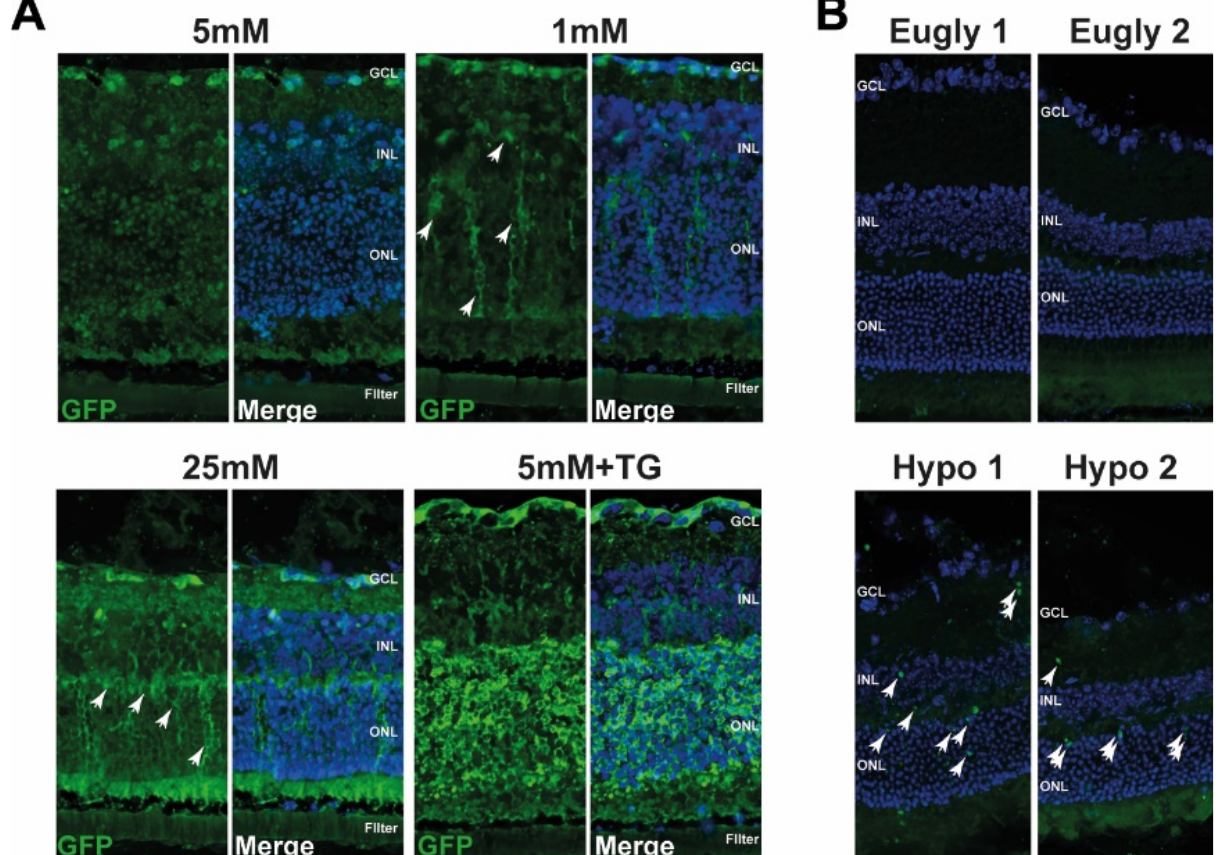
Figure 3. Xbp-1 splicing is activated in ERAI tg/+ retinal explants after 48 h and after a 5 h hypoglycaemic clamp. ( A ) Confocal images showing retinal explants from ERAI tg/+ mice cultured at different glucose conditions (1 mM, 25 mM or 5 mM with or without TG). White arrows indicate GFP-positive cells and nuclei are counterstained with DAPI. Results are representative of 2 retinal explants per condition. ( B ) Endogenous GFP detection (white arrows) in the retina of mice subjected to a hypoglycaemic (Hypo1 and Hypo2) or euglycaemic (Eugly1 and Eugly2) clamp; nuclei are counterstained with DAPI. Eyes were isolated 4 h after the end of the clamp. Results are representative of 4 retinas for each group (Hypo1 and Hypo2 are two different mice, Eugly1 and Eugly2 are two different mice). GCL: ganglion cell layer, INL: inner nuclear layer, ONL: outer nuclear